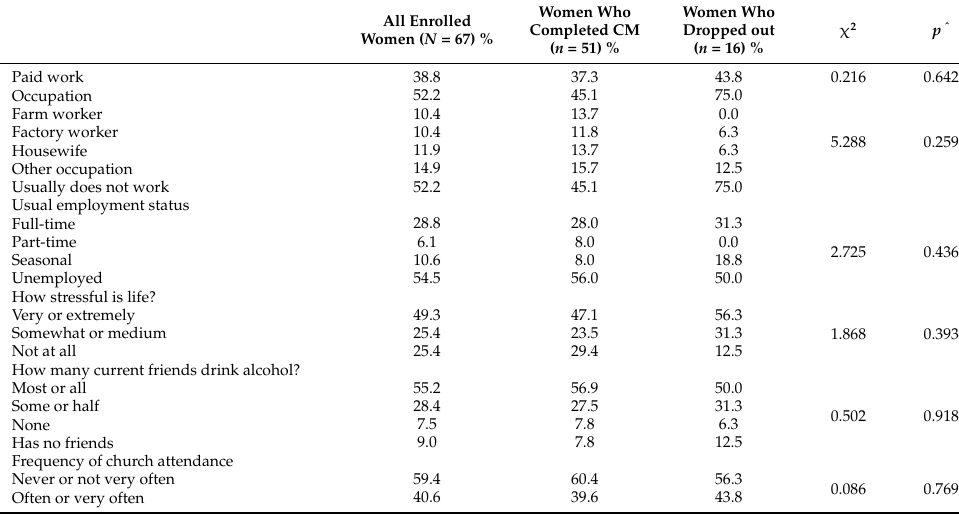
Table 2. Selected social maternal risk factors at baseline for all women enrolled in case management ( N = 67) and comparison of those who completed 18 months of case management ( n = 51) to women who did not ( n =